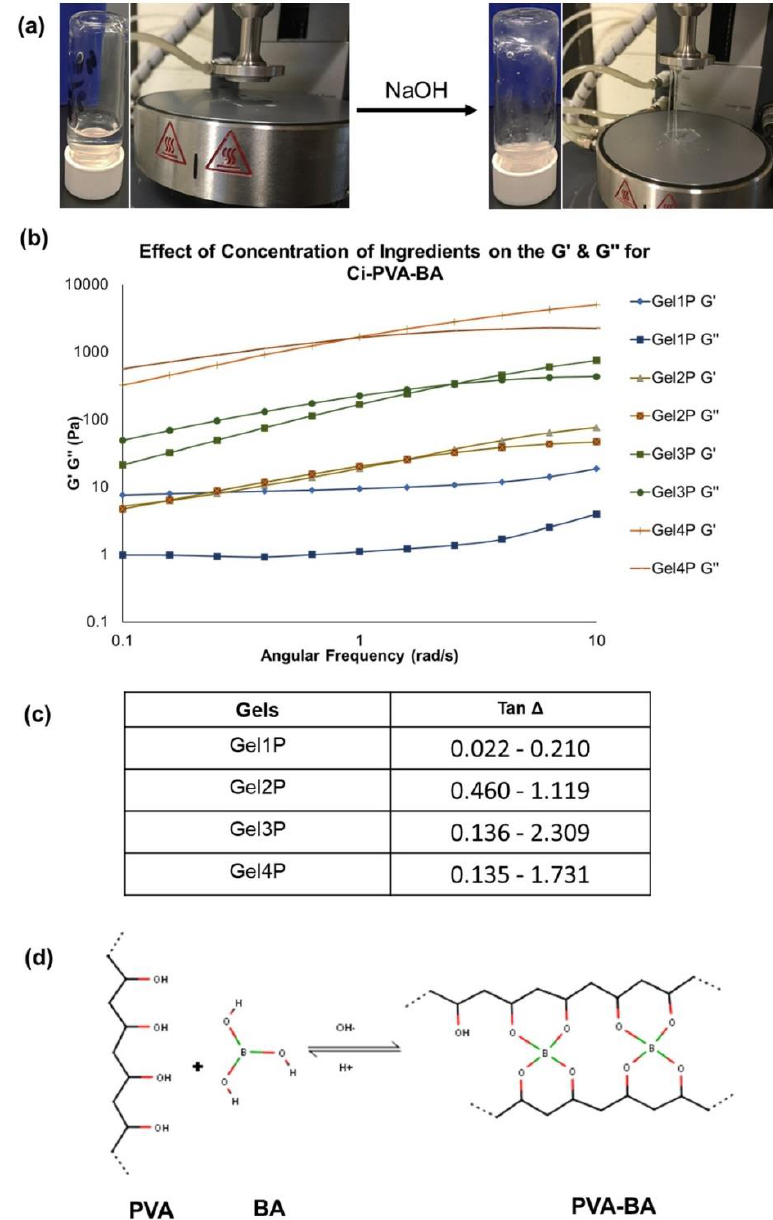
Figure 6. ( a ) Physical observations of Gel 4P (representative C i -PVA-BA gel) showing that it as a soft, weak, flowing gel at acidic pH of ~4–4.5 with no spinnbarkeit behavior whereas, increasing the pH to 7–8 generated a chemically cross-linked system with characteristic spinnbarkeit. ( b ) Effect of polymers and cross-linker concentrations on the conversion of physical to chemically cross-linked gels after adjusting the pH from acidic to 7–8, analyzed through G′ and G″ modulus crossover frequency measurements. ( c ) Tan ∆ values for Gel 1P to Gel 4P. ( d ) Representative cross-linking reaction between PVA and BA under acidic and basic pH conditions